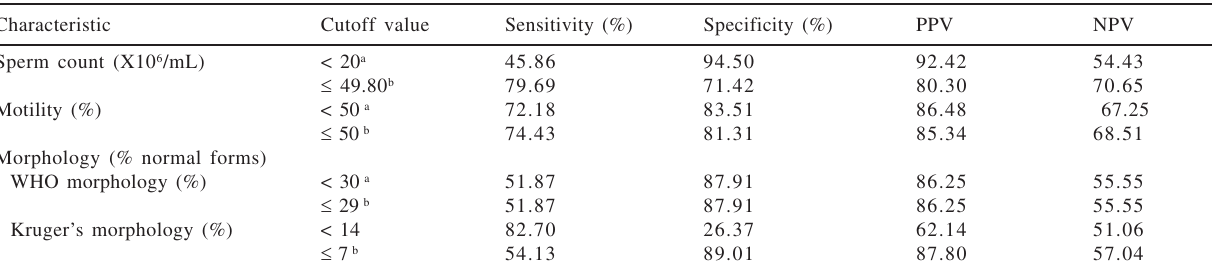
Table 3 - Characteristics in correctly identifying the male factor infertility patients using calculated and World Health Organization (WHO) established cutoff for various sperm parameters Characteristic